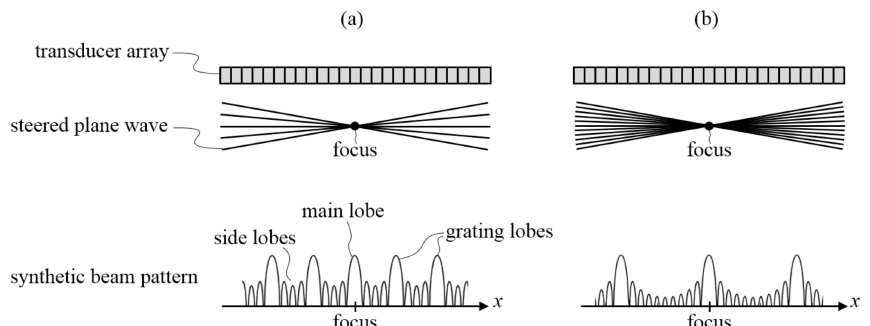
Figure 1. Schematic diagrams of a linear transducer array, transmitted plane waves (PWs) with uniformly distributed steering angles, and the synthetic transmit (Tx) beam pattern when ( a ) five PWs with a larger steering angle interval and ( b ) eleven PWs with a smaller angle interval are compounded. As the number of compounded PWs increases when the total range of the steering angle is fixed, the side lobe level decreases and grating lobes (GLs) occur less